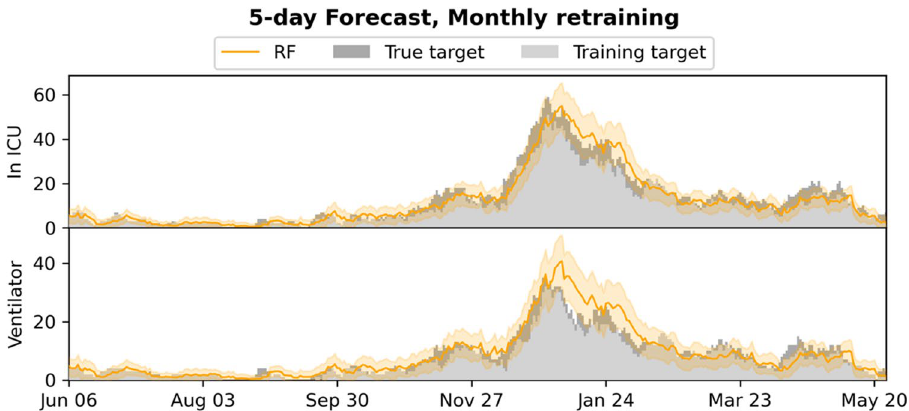
Figure 3. 5-day forecasts of admission to ICU and use of mechanical ventilation, compared to the training and true targets in the monthly retrained setting. The estimated 95% confidence intervals are shown.